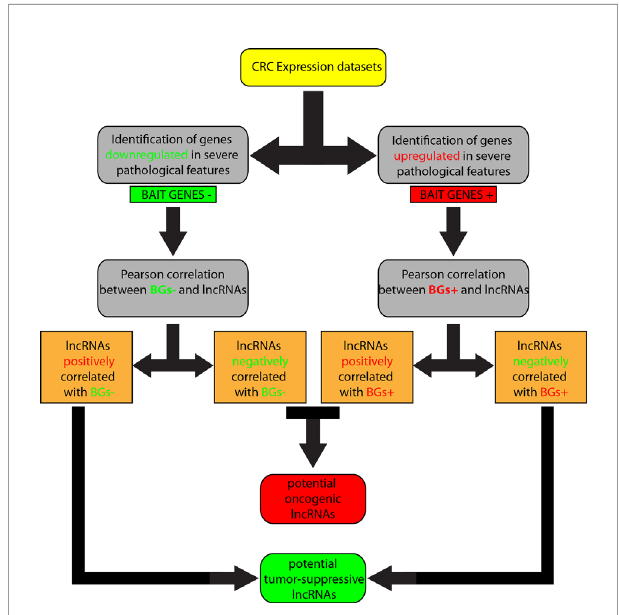
FIGURE 1 | Work fl ow of the computational approach followed to identify l ong non-coding RNAs (lncRNAs) associated to colorectal cancer